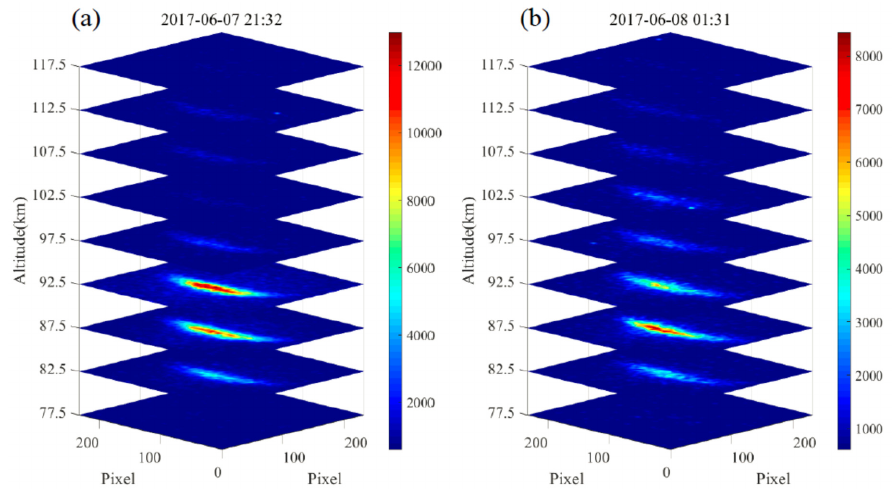
Figure 4. Multi-Na layer imaging experiment conducted at local time 21:32 on 7 June ( a ) and at 01:31 on 8 June ( b ) 2017, respectively. Horizontal axis is the number of